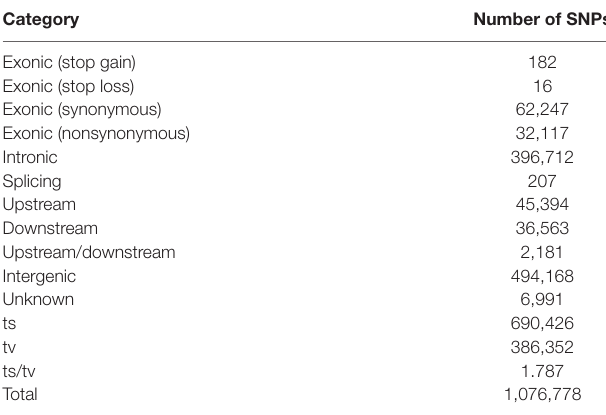
TABlE 1 | Summary of the single-nucleotide polymorphisms (SNPs) in Cynoglossus semilaevis